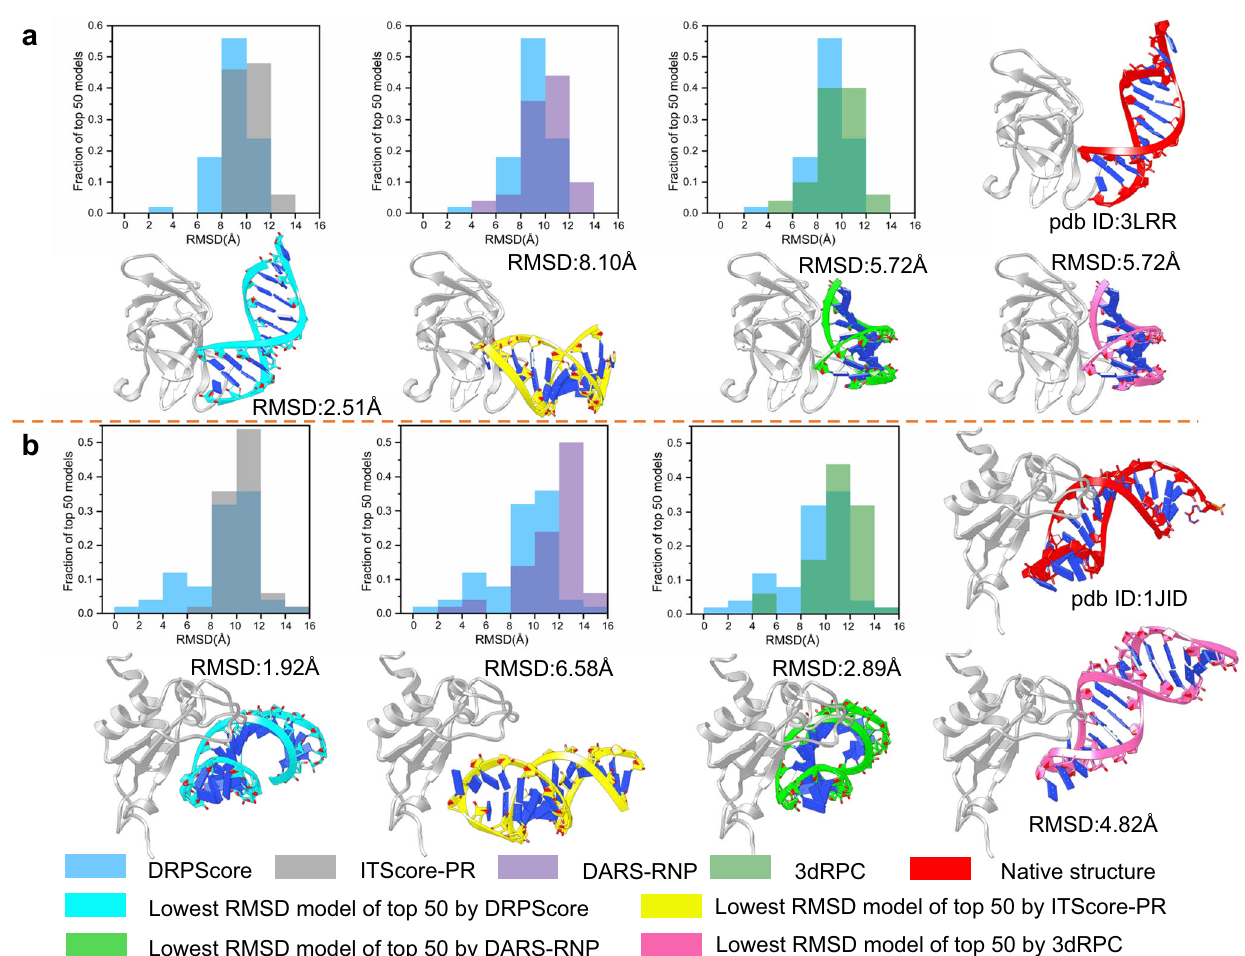
Fig. 4 | Two examples of native-like structures ranking analysis. a Unbound- bound (PDB ID: 3LRR) and ( b ) unbound-unbound (PDB ID: 1JID) testing sets. The histograms(lefttoright)aretheRMSD(RootMeanSquareDeviation)distributions relative to native structurein the top 50 predictions of DRPScore(blue) compared withITScore-PR(gray),DARS-RNP(purple),3dRPC(green),respectively.DRPScore